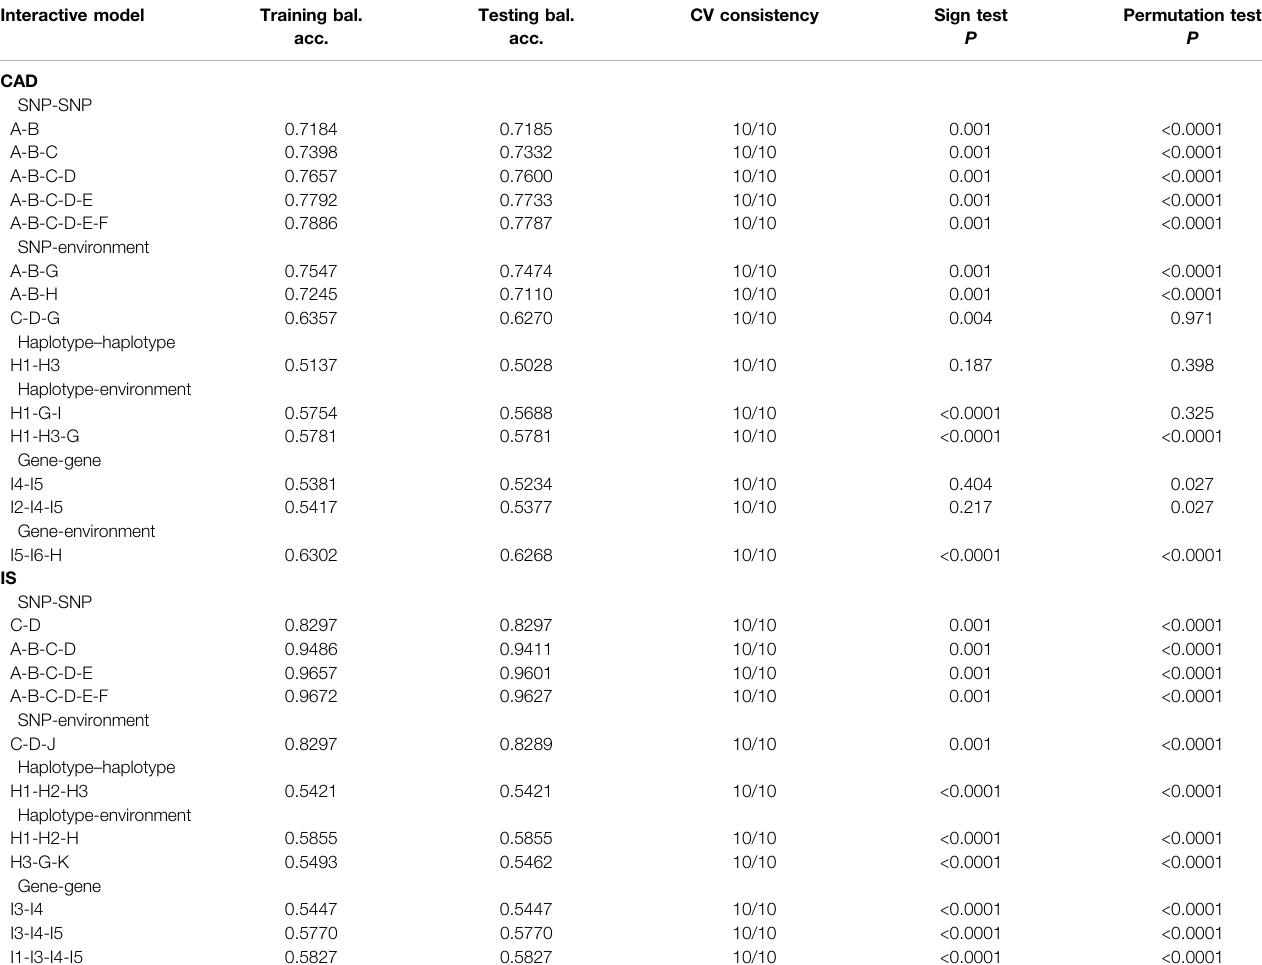
TABLE 8 | Different types of interaction models related to CAD and IS. Interactive model Training bal.